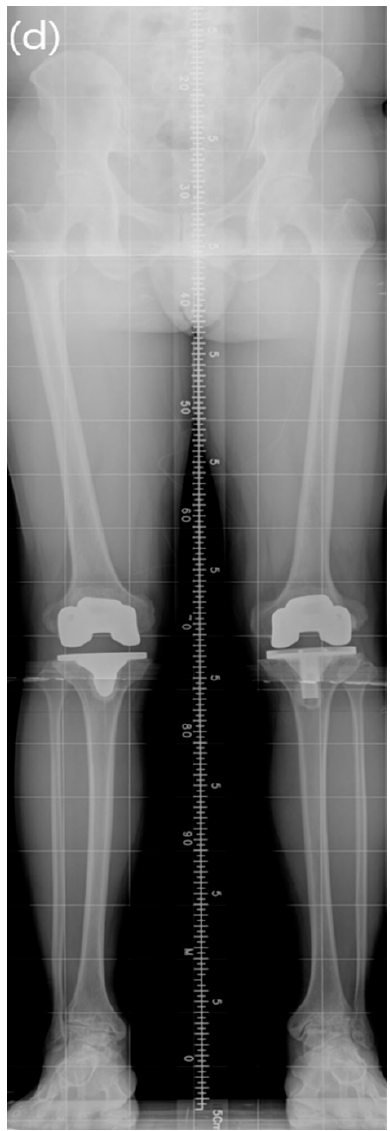
Figure 1. A 36-year-old hemophiliac male with severe valgus deformity. Flexion contractures of both knees were 10 ◦ on the right and 15 ◦ on the left, respectively. The range of motion (ROM) in both knees was limited to 120 ◦ . ( a ) Preoperative standing anteroposterior and lateral radiographs. ( b ) A preoperative lower-extremity orthogram showed 15 ◦ valgus of the right lower limb and 14 ◦ valgus of the left lower limb. ( c ) A postoperative radiograph taken at 11 years after surgery showed well-positioned components. ( d ) A postoperative lower-extremity orthogram taken at 11 years after surgery revealed neutral alignment in both knees. The ROM of both knees was improved to 140 ◦ without flexion contracture.